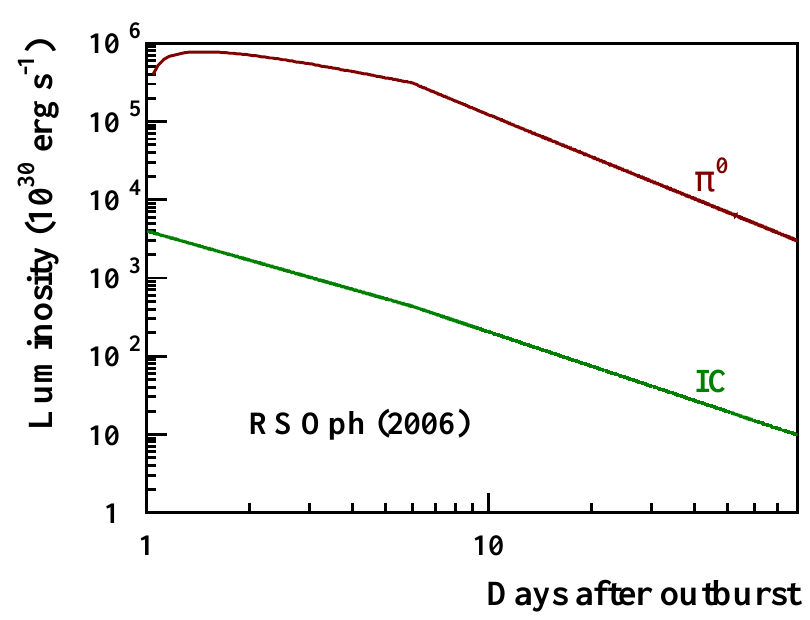
Fig. 3. Evolution with time from outburst of the (cid:13) -ray luminosity (in units of 10 30 erg s (cid:0) 1 ) corresponding to pion production and IC emission in RS Oph (2006).